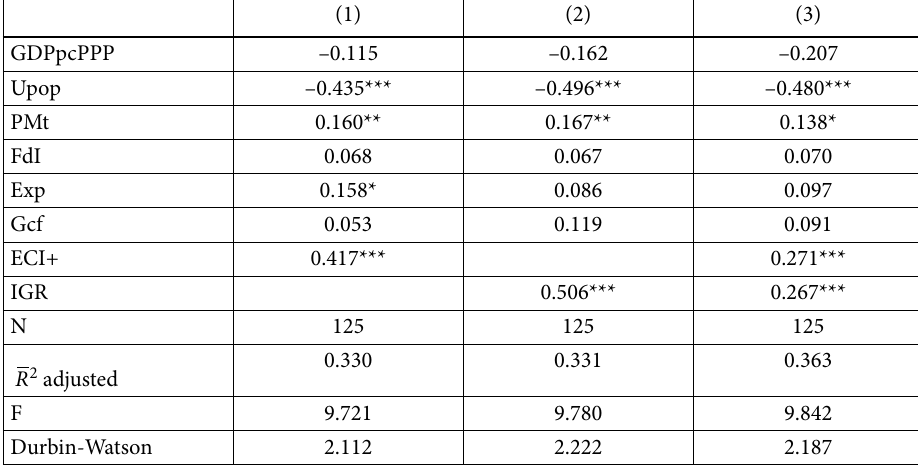
Table 3. Linear regression model analysis